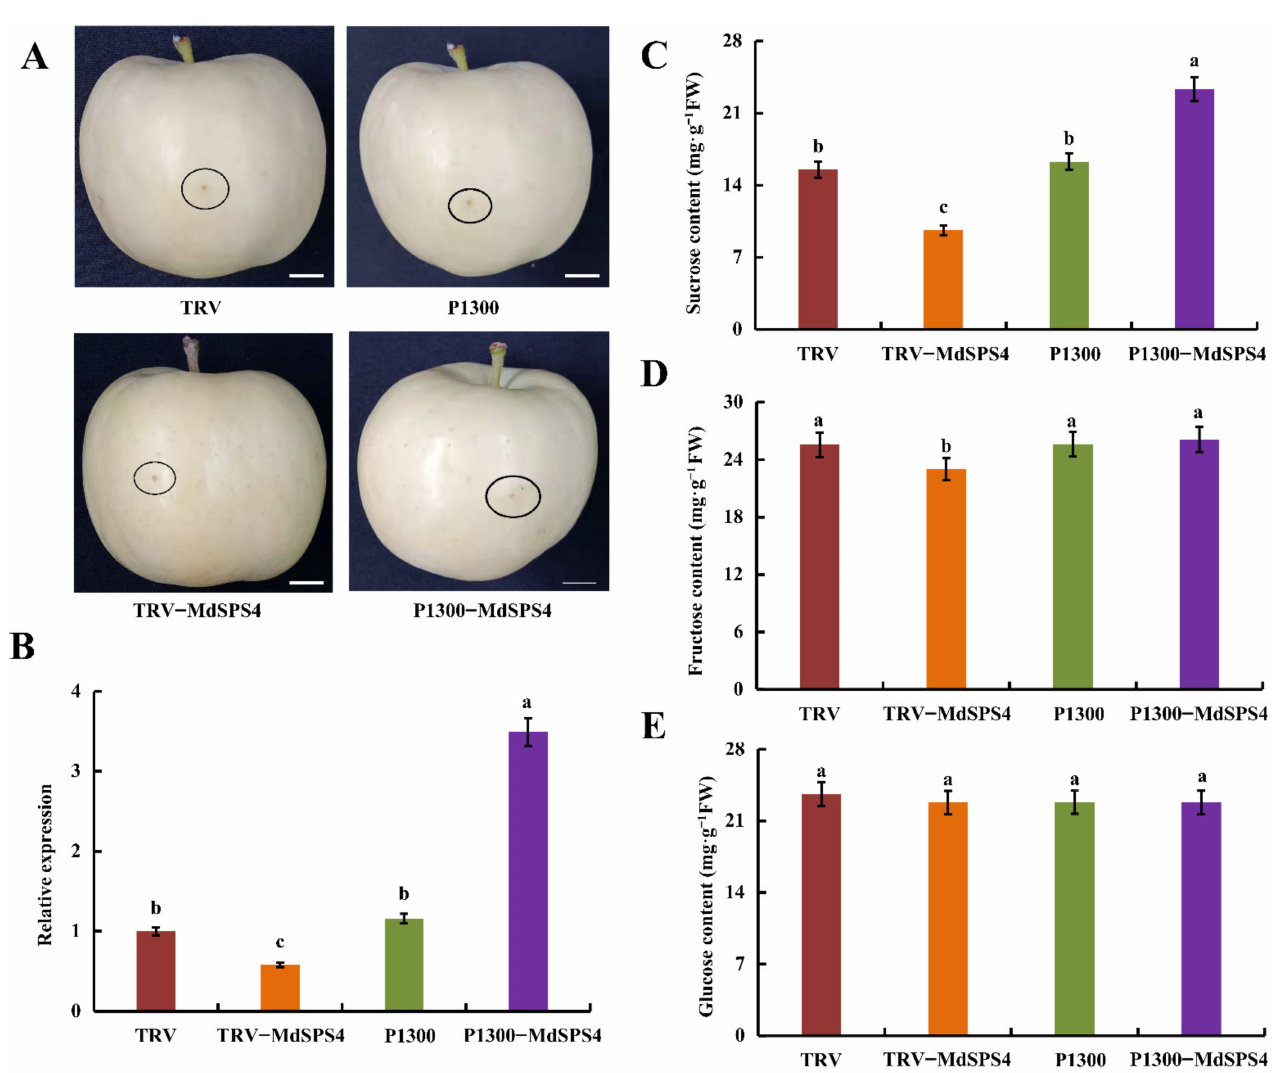
Figure 9. MdSPS4 promotes sucrose accumulation in apple fruit. ( A ) MdSPS4 transient expression in vectors. MdSPS4 cDNA fragment was ligated into the pCAMBIA1300–GFP vector. MdSPS4 antisense cDNA fragment was ligated into the TRV vector. Controls were empty vectors. Bars = 1 cm. ( B ) Relative expression of MdSPS4 at injection sites. ( C ) sucrose content in injected apple fruit. ( D ) fructose content in injected apple fruit. ( E ) glucose content in injected apple fruit. Error bars represent the means ± SD ( n = 3) taken from three independent biological replicates. Different letters represent significant differences (LSD test, p <